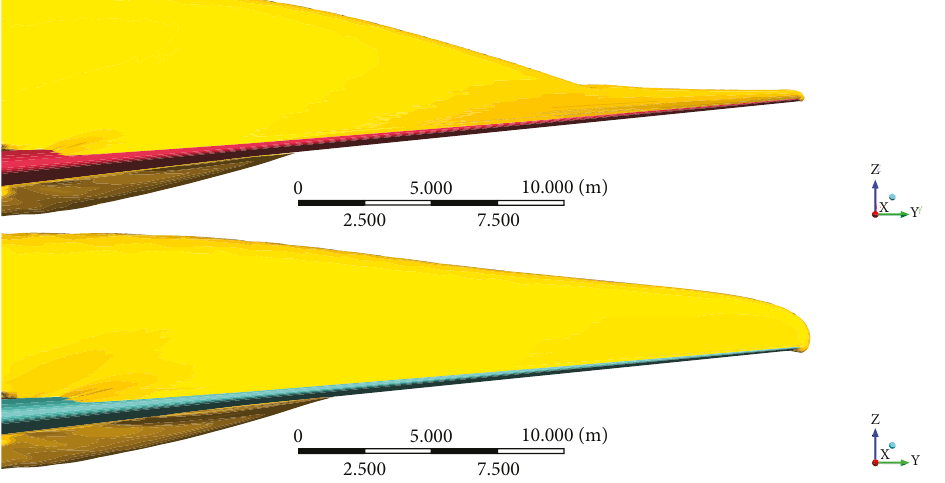
Figure 7: Supersonic regions (front view: h = 10,000m , C